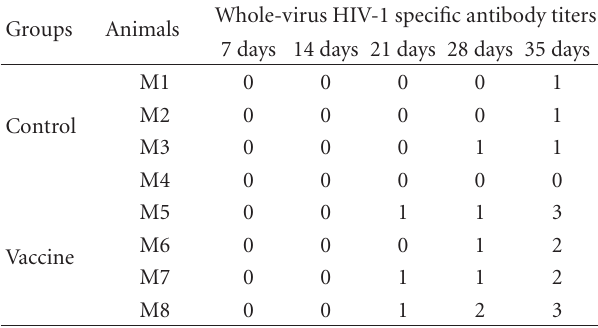
Table 1: Whole-virus HIV-specific binding antibody titers after the